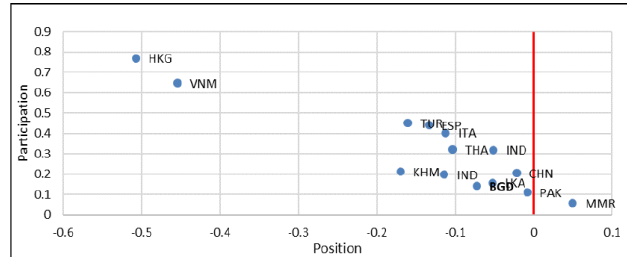
Figure 6: Backward and forward participation of Textile and Apparel sector; Source: